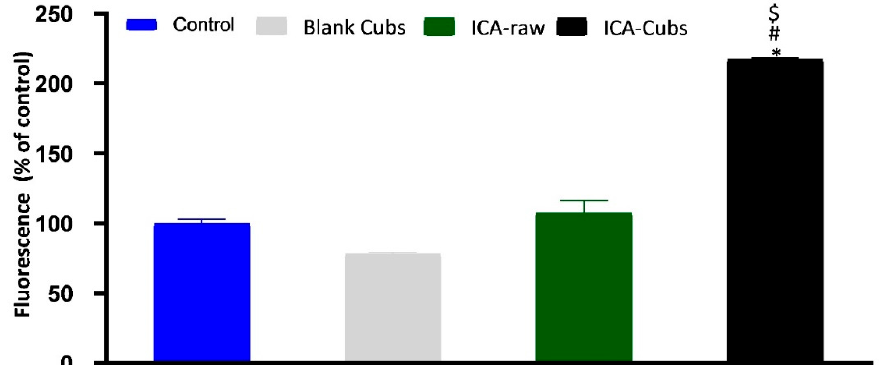
Figure 11. Generation of reactive oxygen species (ROS) in SKOV-3 cells following treatment with blank-Cubs, ICA-raw, and ICA-Cubs. Data are expressed as the mean ± SD (n = 4 runs). * represents a significant difference when compared with untreated cells (control) ( p < 0.05), whereas # represents a significant difference when compared with the blank-Cubs ( p < 0.05) and $ represents a significant difference when compared with the ICA-raw ( p < 0.05).